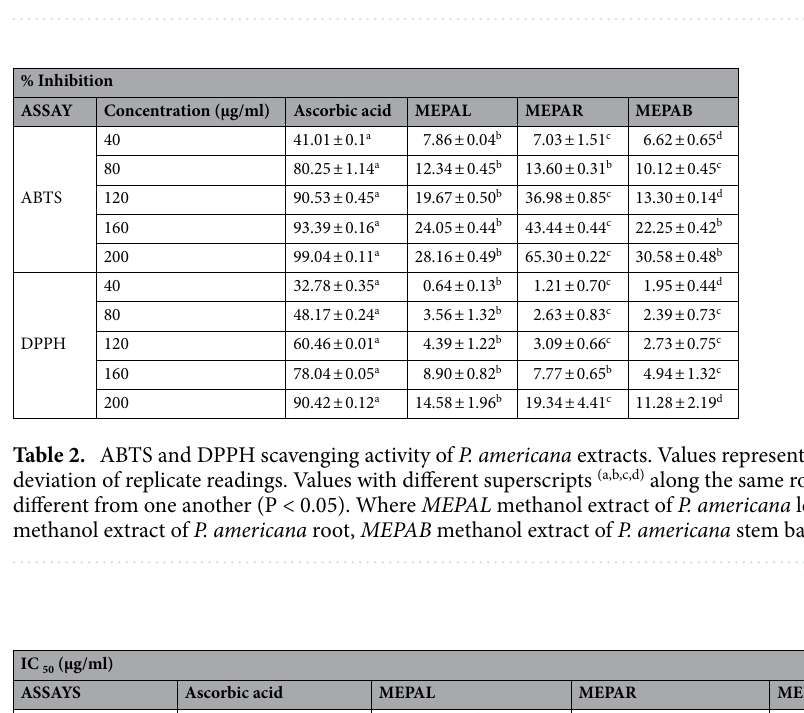
Figure 1. Ferric reducing antioxidant properties (FRAP) and Total reducing activity of P. americana extracts. Where MEPAL methanol extract of P. americana leave, MEPAR methanol extract of P. americana root, MEPAB methanol extract of P. americana stem bark.